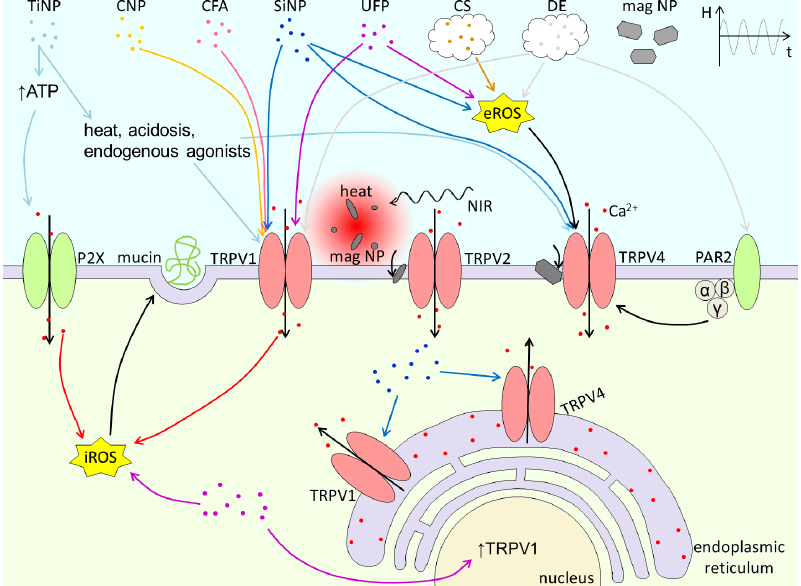
Figure 5. Graphical summary of the activation of TRPV1, TRPV2 and TRPV4 channels by titanium NPs (TiNP), carbon NPs (CNP), coal fly ash (CFA), silica NPs (SiNP), ultrafine ambient particles (UFP), cigarette smoke (CS), diesel exhaust (DE) and magnetic particles (mag NP).